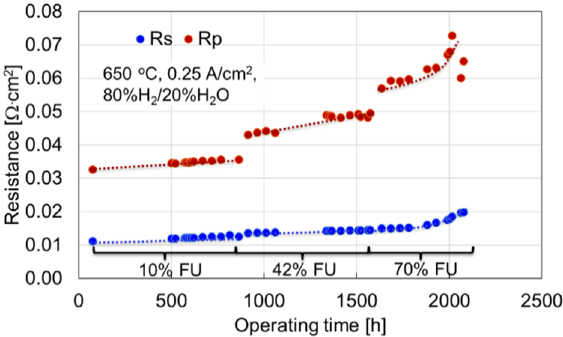
Figure 9. Development of the area specific serial (Rs) and polarization (Rp) resistance during MSC operation in SOFC mode at 650 °C, with 20% H 2 O in H 2 fuel and 0.25 A/cm 2 . Fuel utilization was changed from 10 to 42, and finally to 70% as indicated in the figure.